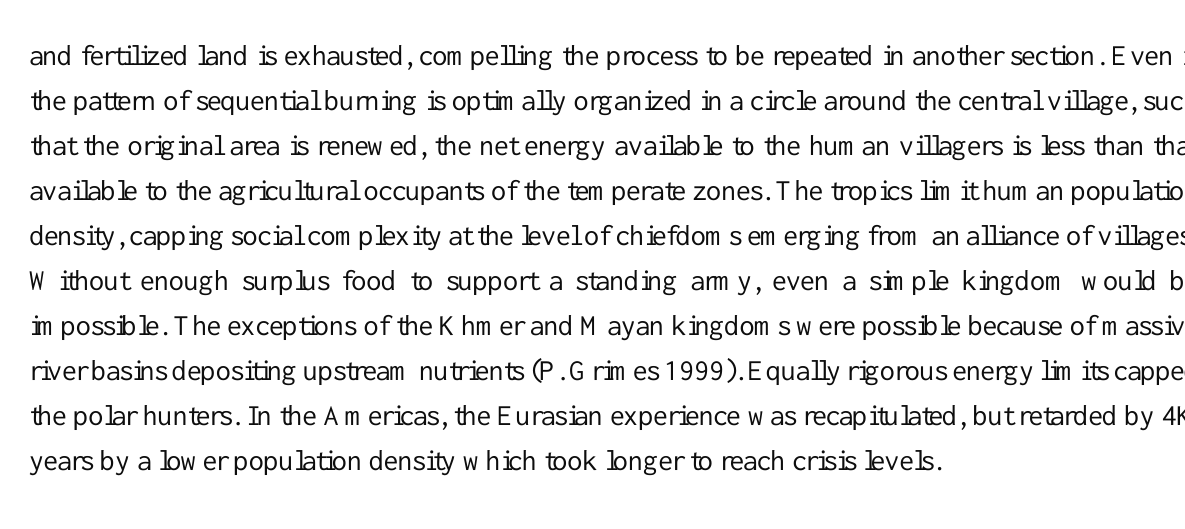
Figure 12. The River Cities Enclosed By Hammurabi Over The 42 Years Between 1792 And 1750